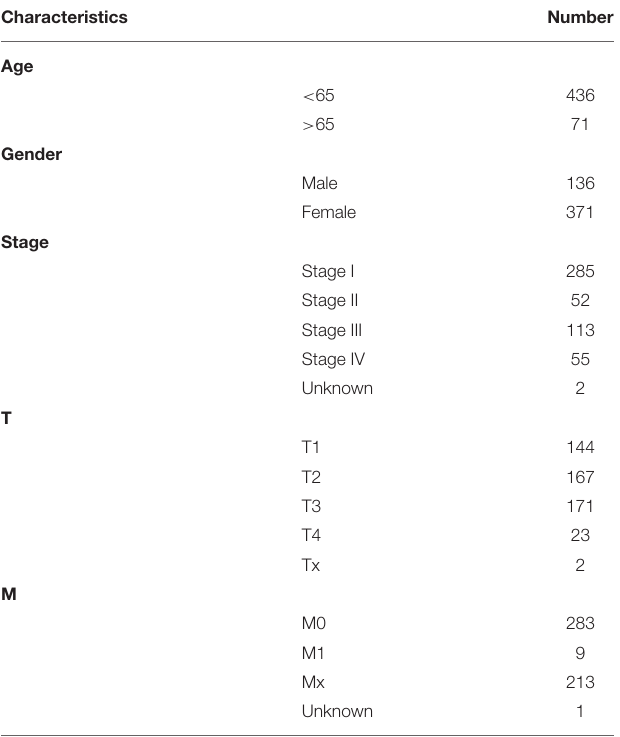
TABLE 1 | The clinical characteristics of thyroid cancer patients. Characteristics